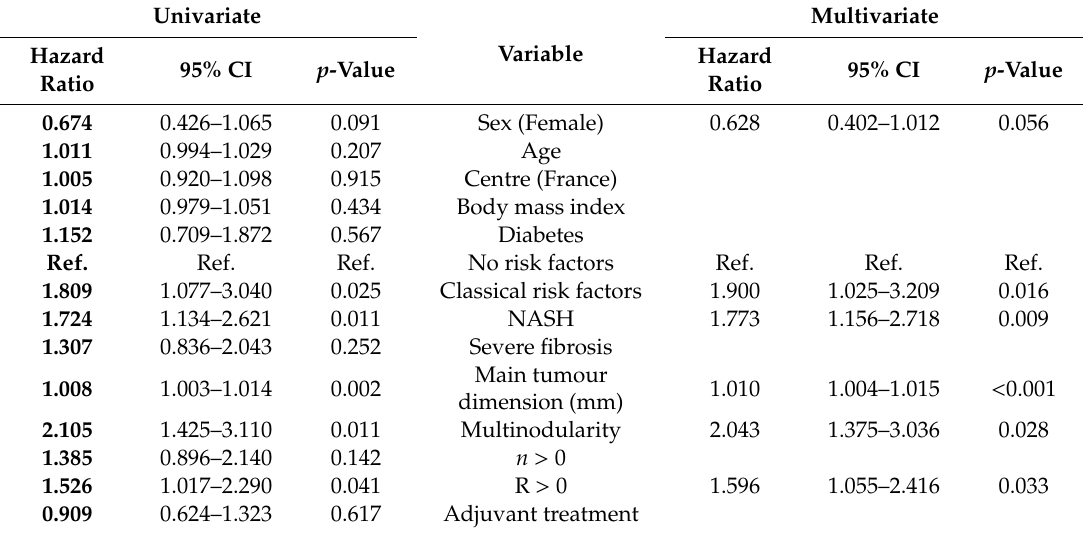
Table 5. Univariate and multivariate Cox regression analysis of overall survival in the whole study population ( n = 180). Univariate Variable